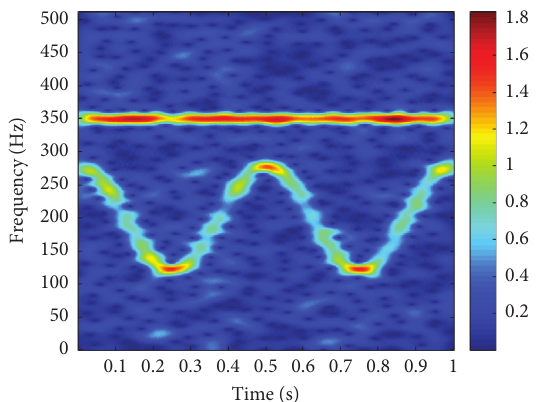
Figure 6: Short-time Fourier Transform of analog signal.